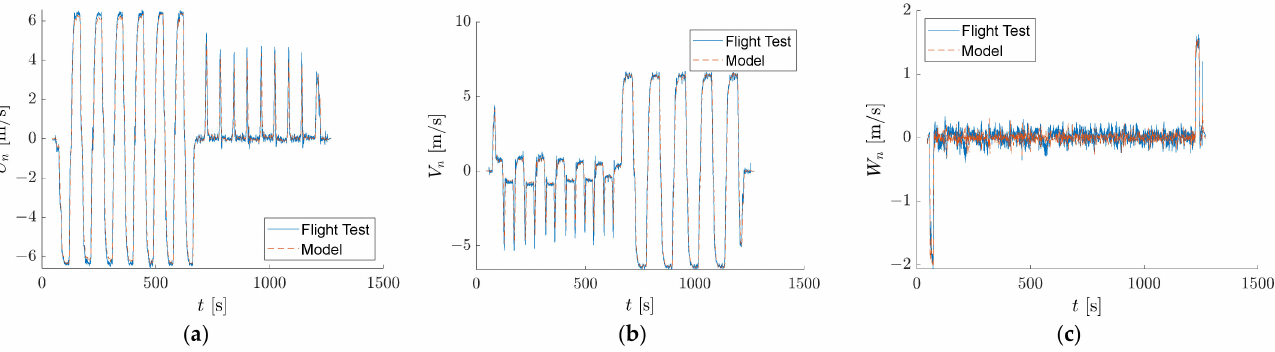
Figure 17. Linear velocities: ( a ) north–south, ( b ) west–east, and ( c ) vertical.